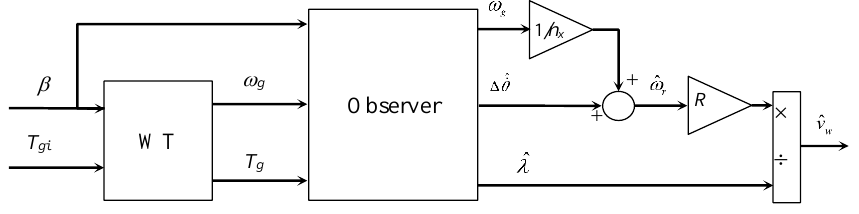
Figure 5. Estimation of the effective wind speed based on the observer.